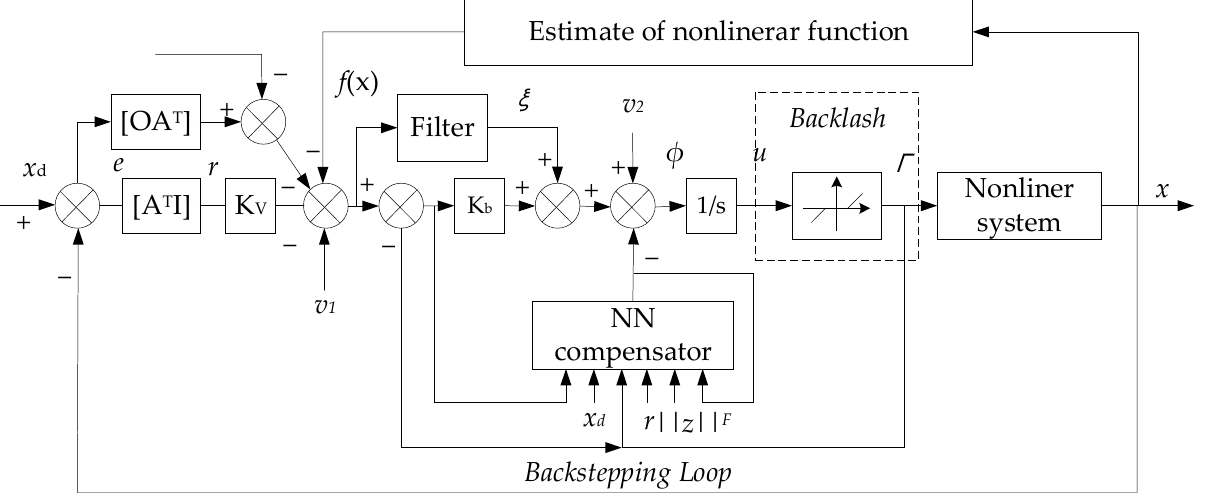
Figure 5. Neural network feedforward control structure.